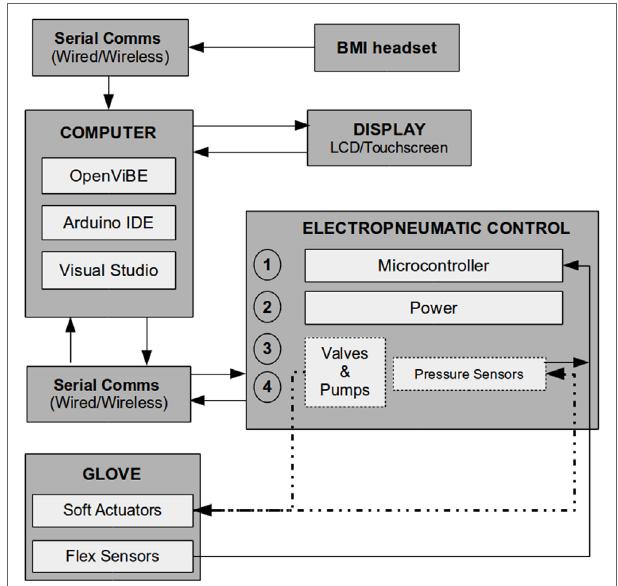
FigUre 4 | a block diagram showing the hardware and software used in this system . The data flow in the Soft Orthotic Physiotherapy Hand Interactive Aid system begins with the brain–machine interface (BMI) as the initial trigger, the data from is then passed to the software running on the computer, and the outputs are sent to the display and to the electropneumatic controller, and finally the soft robotic glove system applies torque to the